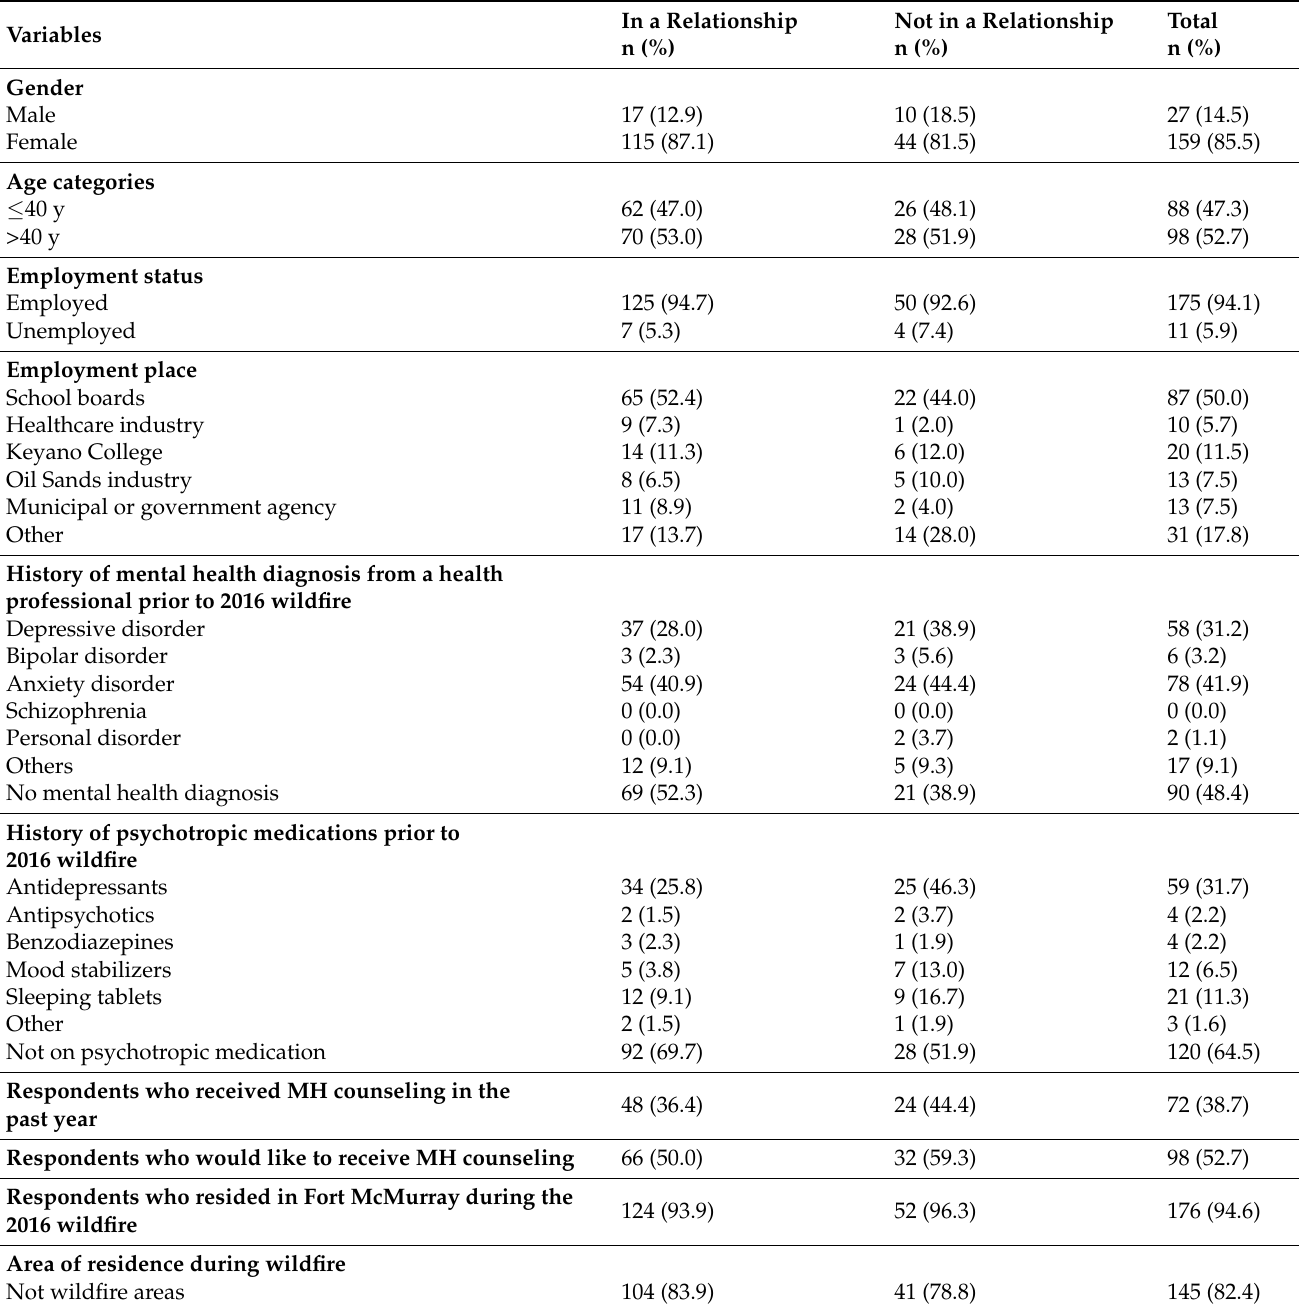
Table 1. Demographic information, clinical characteristics, and support received by